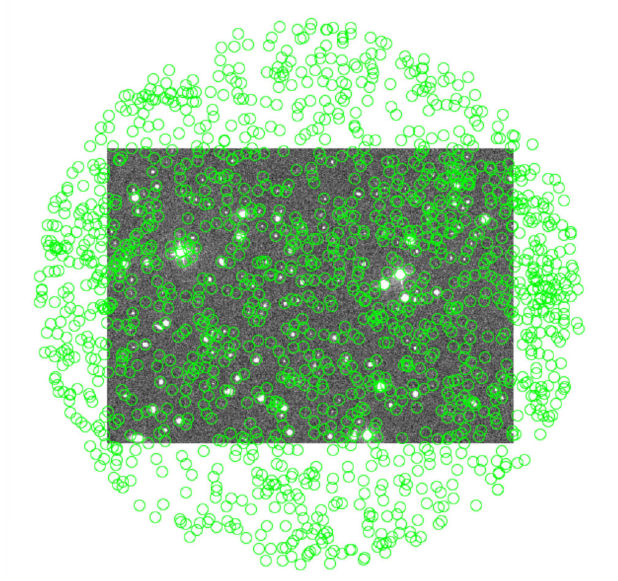
Fig. 42.— Zoomed-out version of our SDSS image, with SDSS DR9 catalog stars circled in green For an image with accurate positioning data (con- tained, as we have seen, in the FITS header), DS9 can show the positions of the known stars. To display them, go to the main window’s top menu. From the dropdown menu “Analysis,” go to the “Catalogues” dropdown sub- menu, from there to “Optical” and there, choose “SDSS Release 9,” which is the catalog associated with the im- age’s data release. If you zoom out sufficiently far, your main image will look as in Fig. 42. The image, and the surrounding area, are covered in small green circles, and each circle marks a star (or possibly other object) that is listed in the SDSS DR9 catalogue.